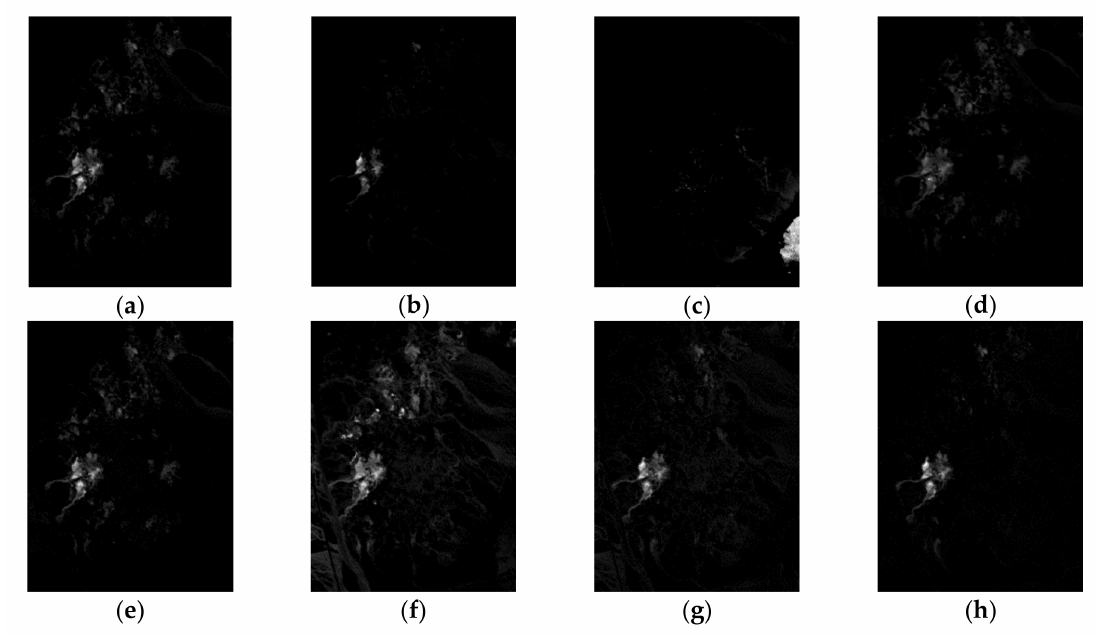
Figure 17. Buddingtonite: ( a ) VCA, ( b ) N-FINDR, ( c ) SGA, ( d ) C-NMF, ( e ) MVC-NMF, ( f ) ICE, ( g ) SPICE, ( h ) SPEEVD.